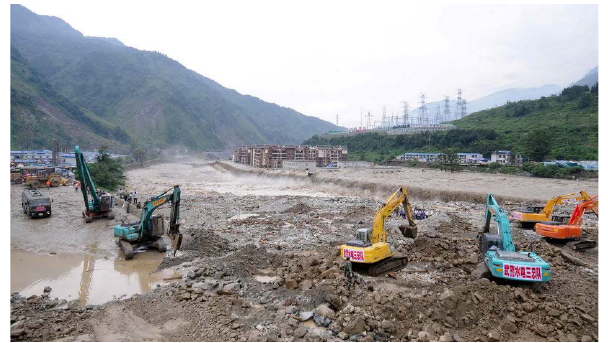
Fig. 12. Distribution of hourly and cumulative precipitation between August 12 and 14, 2010 in Yingxiu Town.